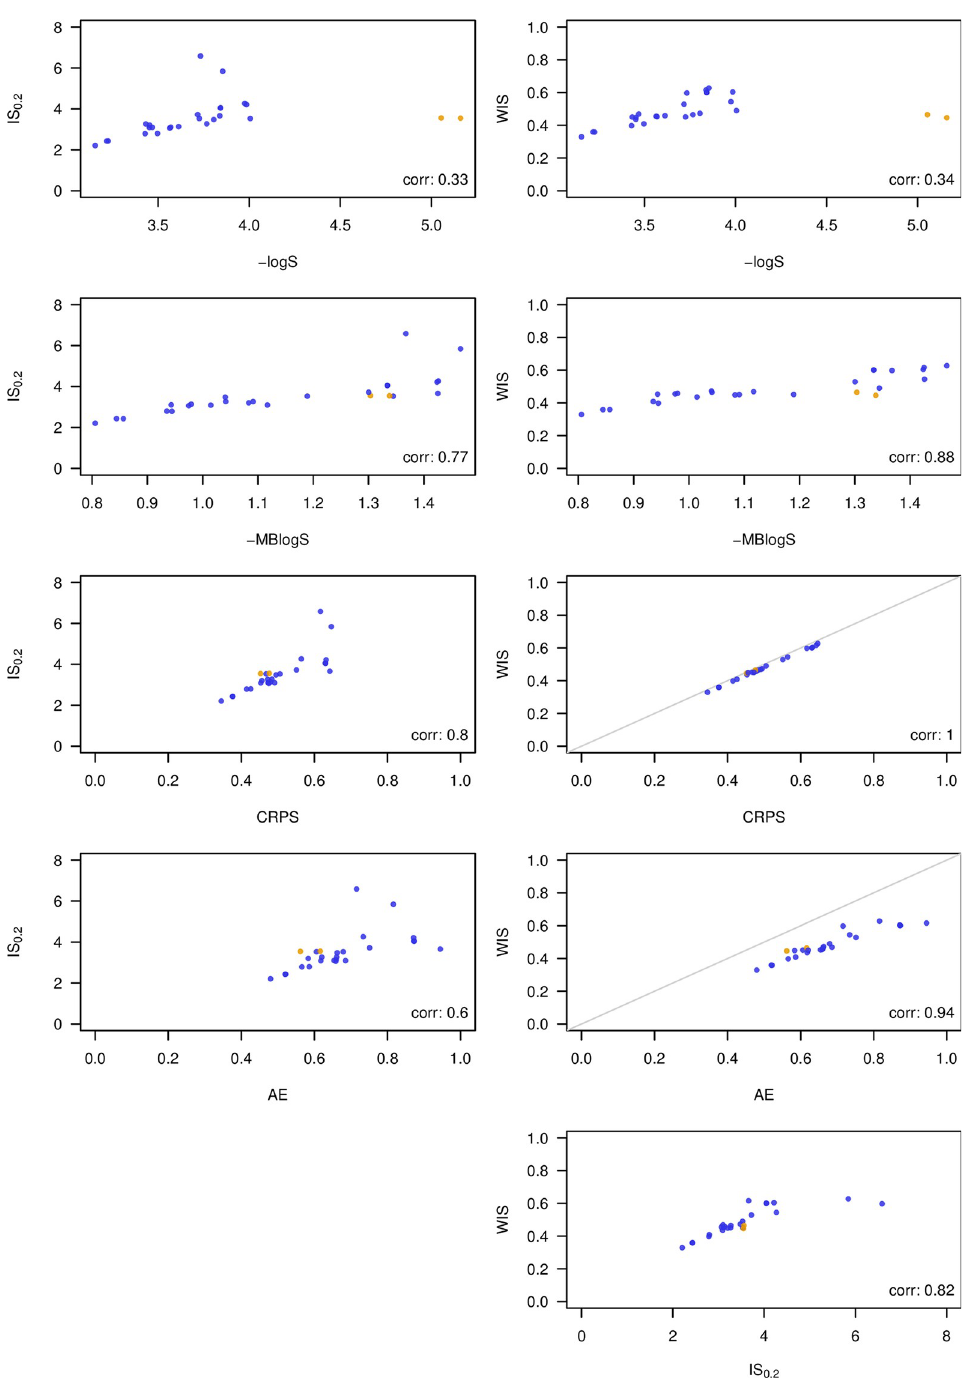
Fig 6. Comparison of 26 models participating in the 2016/2017 FluSight Challenge under different scoring rules. Shown are mean scores averaged over 1- through 4-week-ahead forecasts, different geographical levels, weeks, and forecast horizons. Compared scores: negative logarithmic score and multibin logarithmic score, continuous ranked probability score, interval score ( α = 0.2 ), weighted interval score with K = 11 . Plots comparing the WIS to CRPS and AE, respectively, also show the diagonal in gray as these 3 scores operate on the same scale. All shown scores are negatively oriented. The models FluOutlook_Mech and FluOutlook_MechAug are highlighted in orange as they rank very differently under different